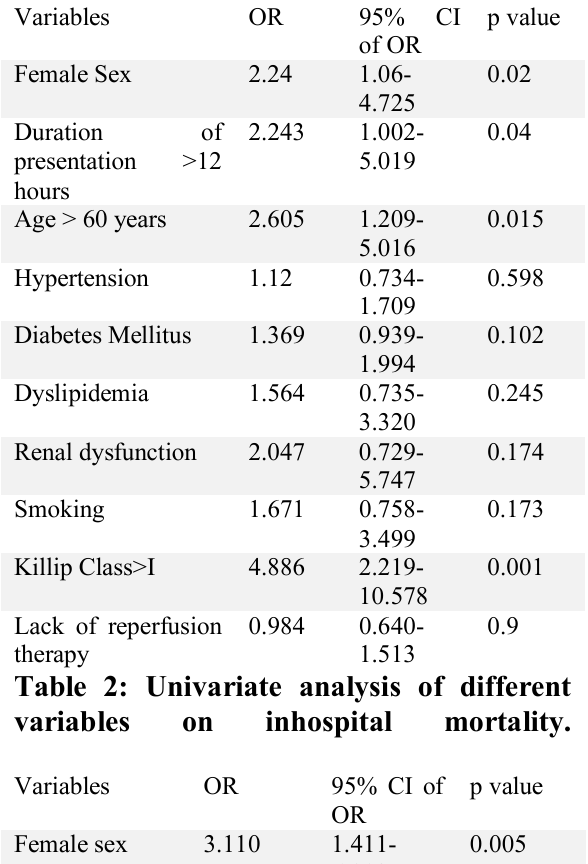
Table 3: After multivariate analysis of effects of different variables on inhospital mortality